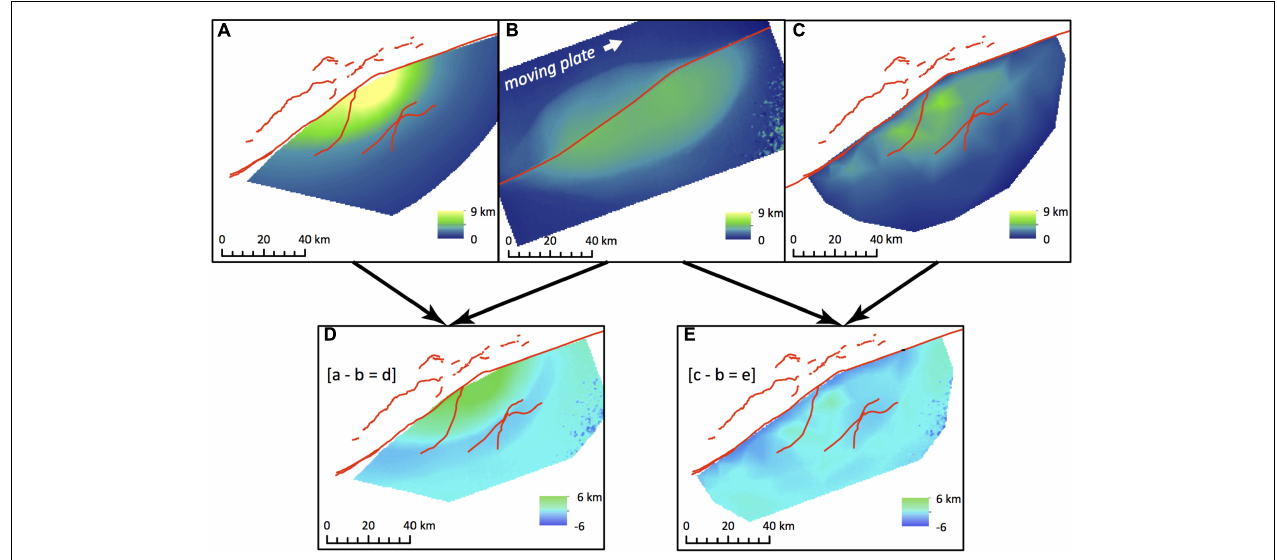
FIGURE 7 | Surfaces representing two geologic constraints on uplift in the Mount McKinley restraining bend (A,C) and the surface from the wet kaolin analog experiments (B) . Red lines illustrate modern fault traces derived from Reed and Nelson (1980), Haeussler (2008), and Burkett et al. (2016). (A) A rock uplift surface derived from low-temperature thermochronology (Fitzgerald et al., 1995). (B) Equivalent elevation map of the clay experiment, using the scaling relationships of the experiment to convert into the scale of geologic constraints (Fendick, 2016). (C) An approximation of a minimum rock uplift surface derived by extrapolating between modern peak and ridge elevations in the Mount McKinley restraining bend (Fendick, 2016). Surfaces (D) and (E) are difference maps used to compare the cumulative uplift in the experiment (B) to the geologic constraints (A,C) . (D) The difference between thermochronology-derived uplift (A) and the experiment (B) . (E) The difference between the minimum rock uplift (C) and the experiment (B) . Positive values (green) represent areas where the experiment did not produce as much uplift as the geologic constraints and negative values (blue) show where the experiment produced more